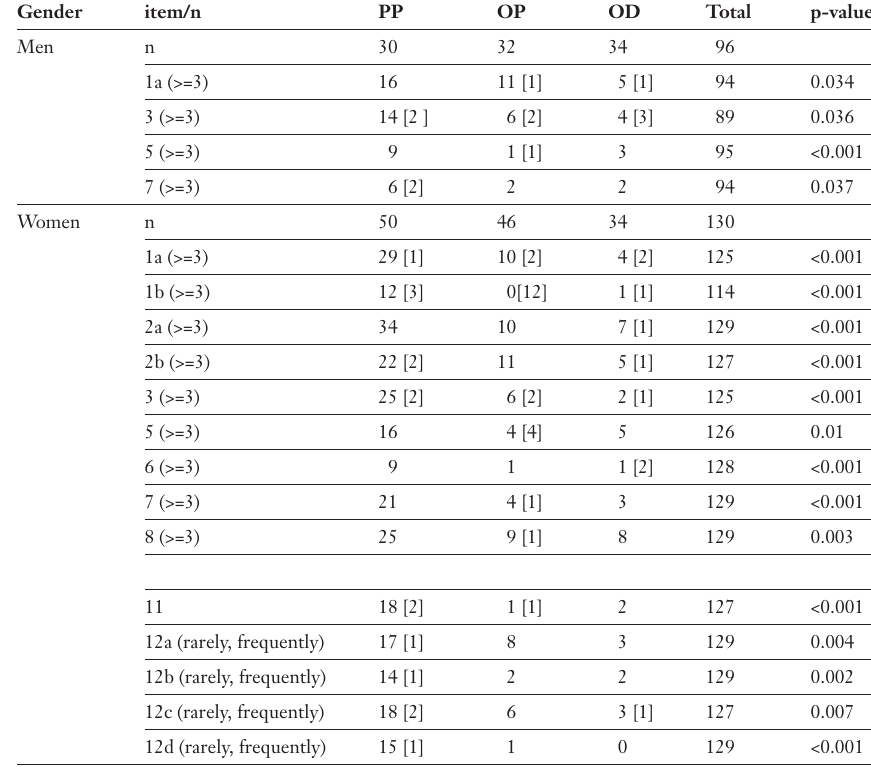
Table 2 Traumatic Childhood Experiences in the PP-, OP- and OD- groups: Comparison between “never, and once or twice” vs “three times or more”. Table body gives number of cases with >=3 TCE in group specified by column